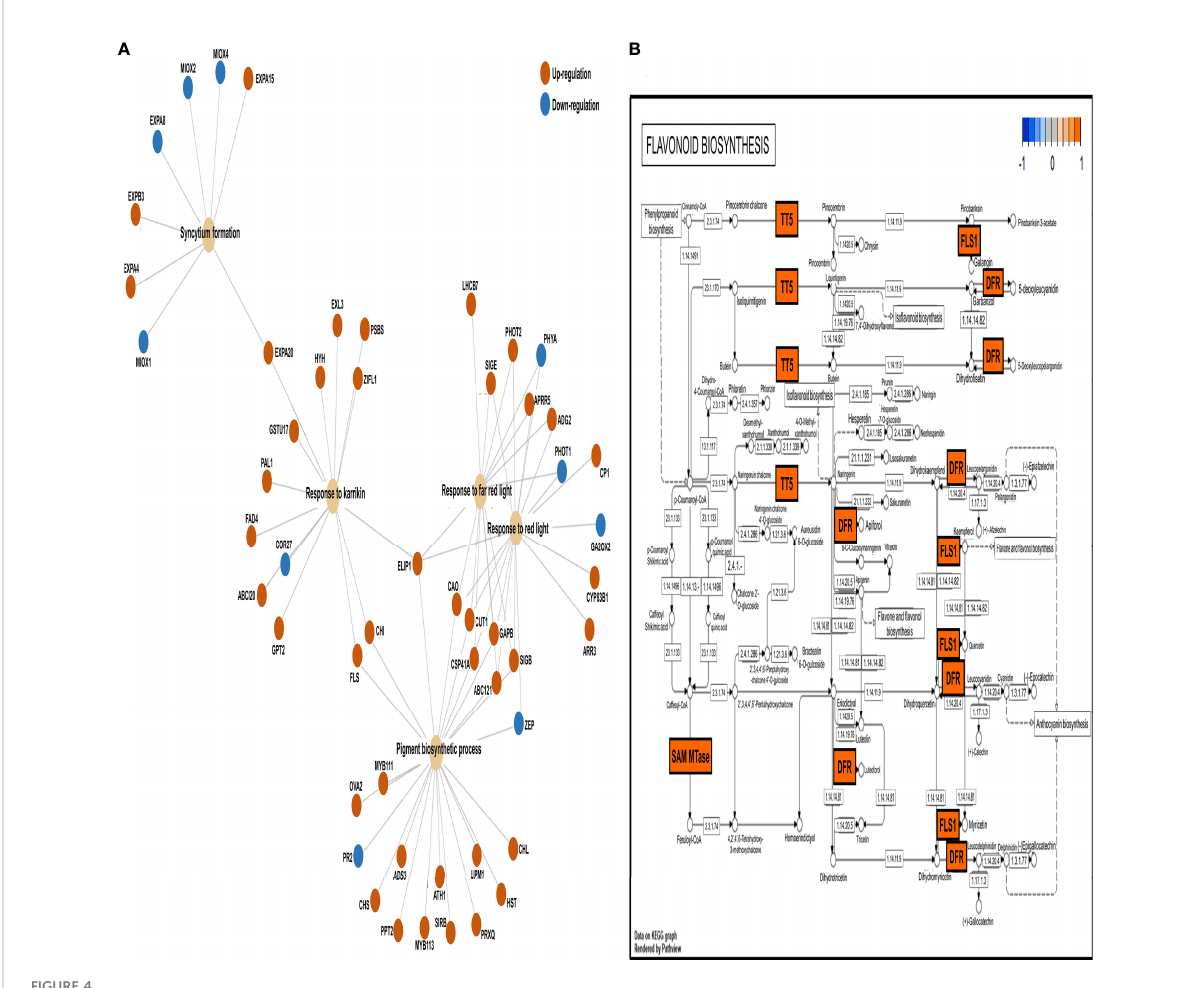
FIGURE 4 Gene set enrichment analysis of CO 2 -responsive genes. (A) The connection of genes among the prominent Gene Ontology (GO) functions based on enrich GO function. The colored circles represent the different regulations of genes with log fold-change (FC) values (red; upregulation, green; downregulation). (B) Expression patterns of differentially expressed genes (DEGs) in the fl avonoid biosynthesis pathway based on Kyoto Encyclopedia of Genes and Genomes (KEGG) database (https://www.genome.jp/kegg/). The DEGs were mapped using the pathview package in R. The colored boxes represent the different gene regulation characteristics based on log FC value (red; upregulation, green; down regulation) (21.1.104 > S-adenosyl-L-methionine-dependent methyltransferases [SAM MTase], 5.5.1.6 > transparent testa 5